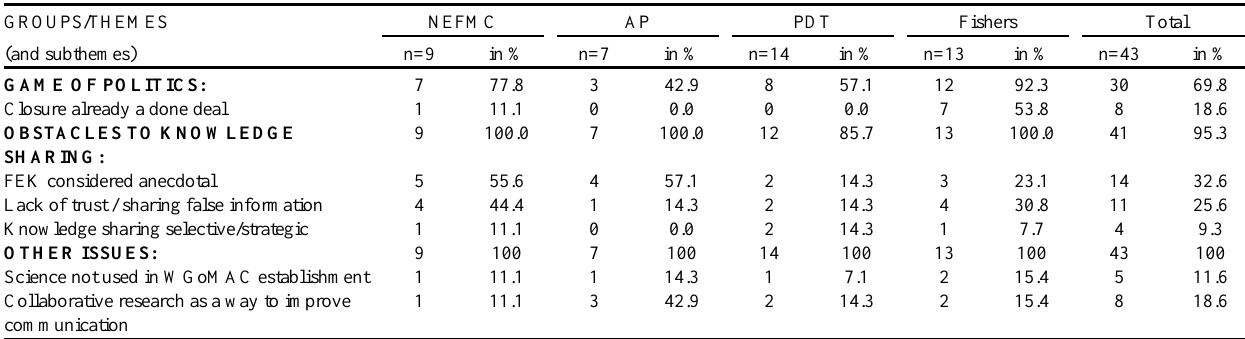
Table 4 . Major themes identified in participants’ comments in the surveys related to the establishment of Western Gulf of Maine Area Closure (WGoMAC) and the use of fishers’ ecological knowledge (FEK). Themes (capitalized, bold letters) were divided into a number of different subthemes (lower case letters) that appeared most frequently. For example, 12 out of 13 fishers identified politics as being an important factor in the process of WGoMAC creation. Out of those 12 fishers, seven had a specific comment that the closure boundaries were “already a done deal.” Columns represent four surveyed